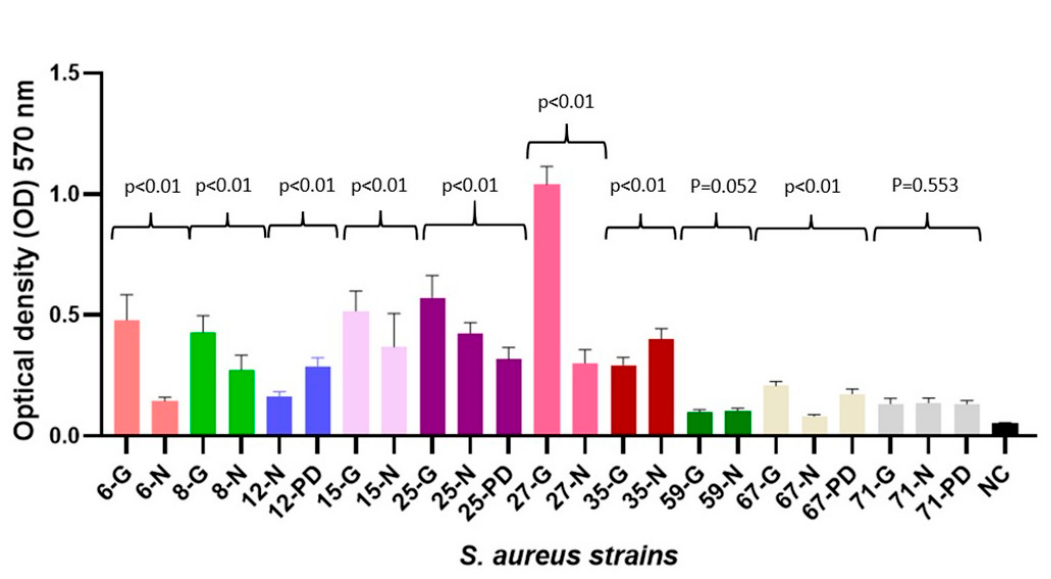
Figure 1. Biofilm production capability on microtiter plate of the 34 clinical isolates of S. aureus and negative control (NC). Bars represent mean values of OD (measured at wavelength of 570 nm). Differences between one suspect S. aureus strain capability in biofilm formation were analyzed using T test and Mann–Whitney U Test for two strain analyses, and one-way ANOVA and Kruskal–Wallis test for three strain analysis and are expressed as p -values.